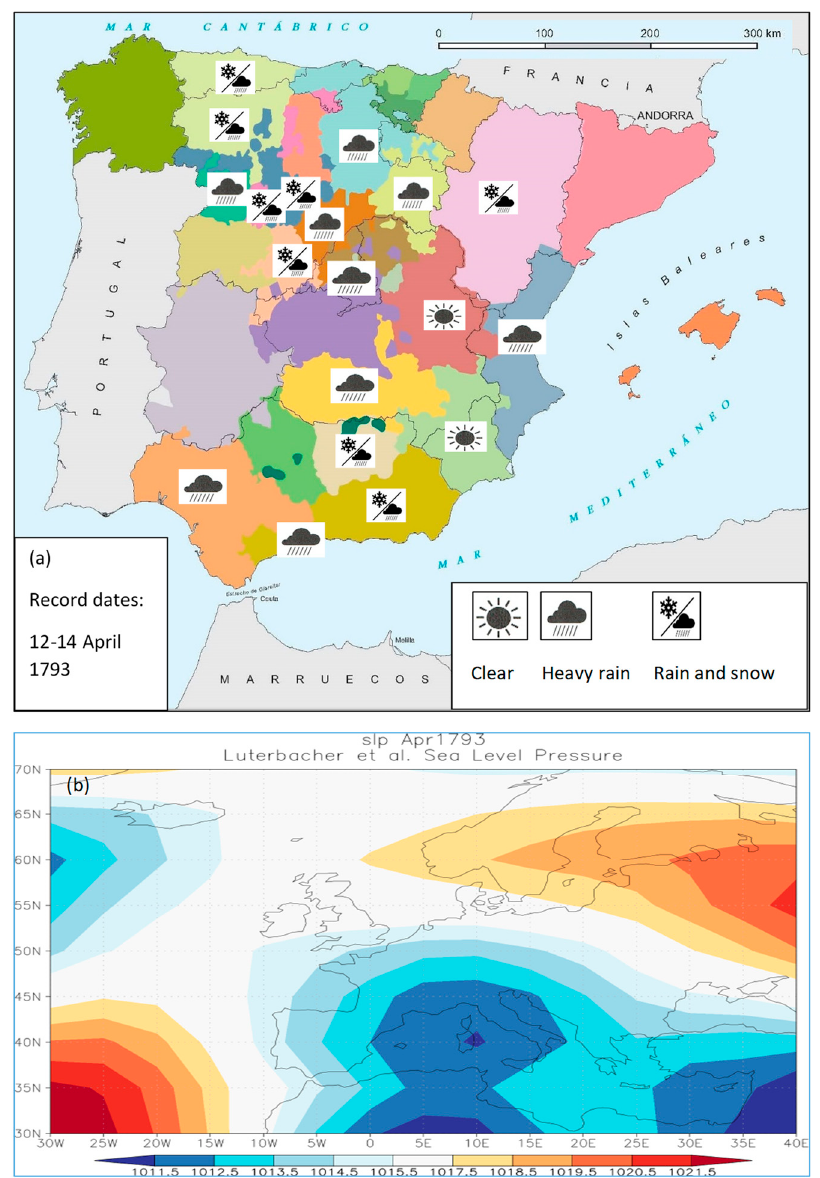
Figure 7. ( a ) Weather information corresponding to 5–13 April 1793 (reports dated from 12 to 14 April 1793, issuexs 8–11, 1793, CMEI). ( b ) SLP field in April 1793.